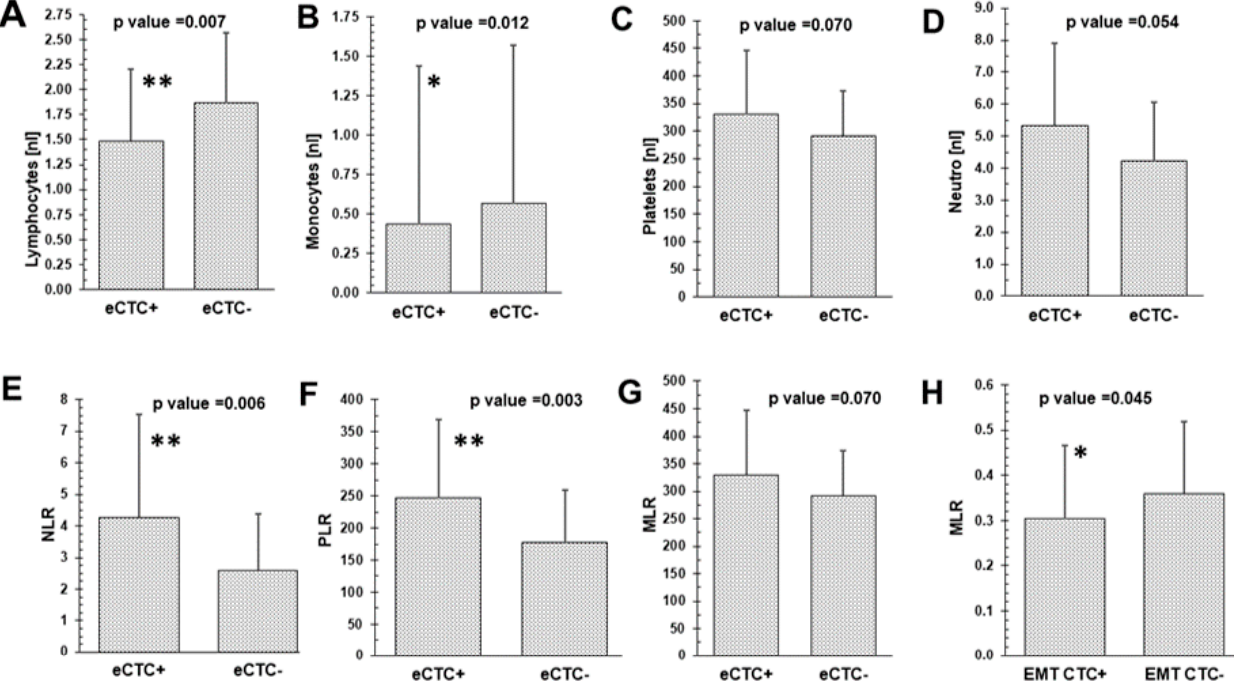
Figure 2. Blood values grouped according to the presence/absence of different CTC subtypes. Differences of median with Mann–Whitney U-test of eCTCs with lymphocytes ( A ), monocytes ( B ), platelets ( C ), neutrophils ( D ), NLR ( E ), PLR ( F ) and MLR ( G ). Differences of median with Mann– Whitney U-test of EMT-CTCs with MLR ( H ). CTCs: epithelial circulating tumor cells; EMT-CTCs: epithelial–mesenchymal transition-circulating tumor cells. MLR: monocyte-to-lymphocyte ratio; NLR: neutrophil-to-lymphocyte ratio; PLR: platelet-to-lymphocyte ratio. * p > 0.05; ** p <